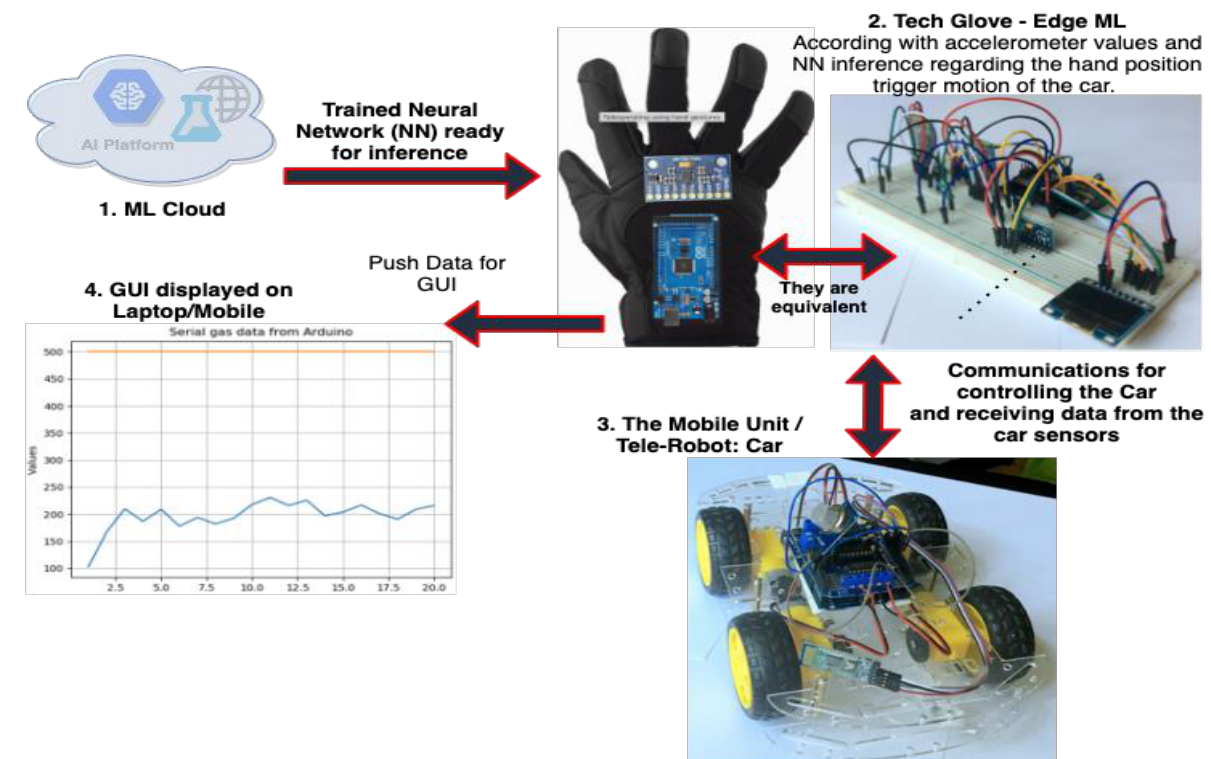
Figure 5. Architecture for the tele-robot PoC.